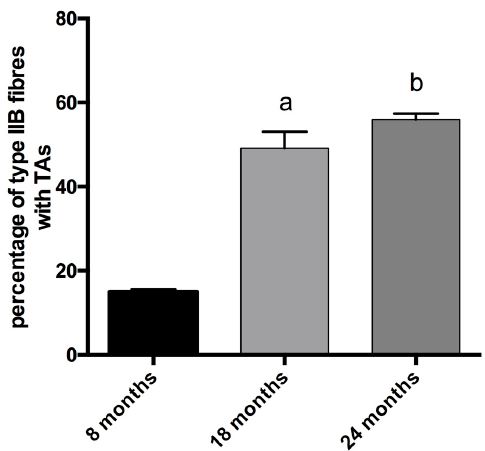
Figure 5. Analysis of the presence of TAs in type-IIB fibers. The percentage of IIB fibers with TAs increases with age (a, significantly different from eight-month-old mice, p < 0.001; b significantly different from eight-month-old mice, p < 0.0001). Data are reported as means ± SEM.